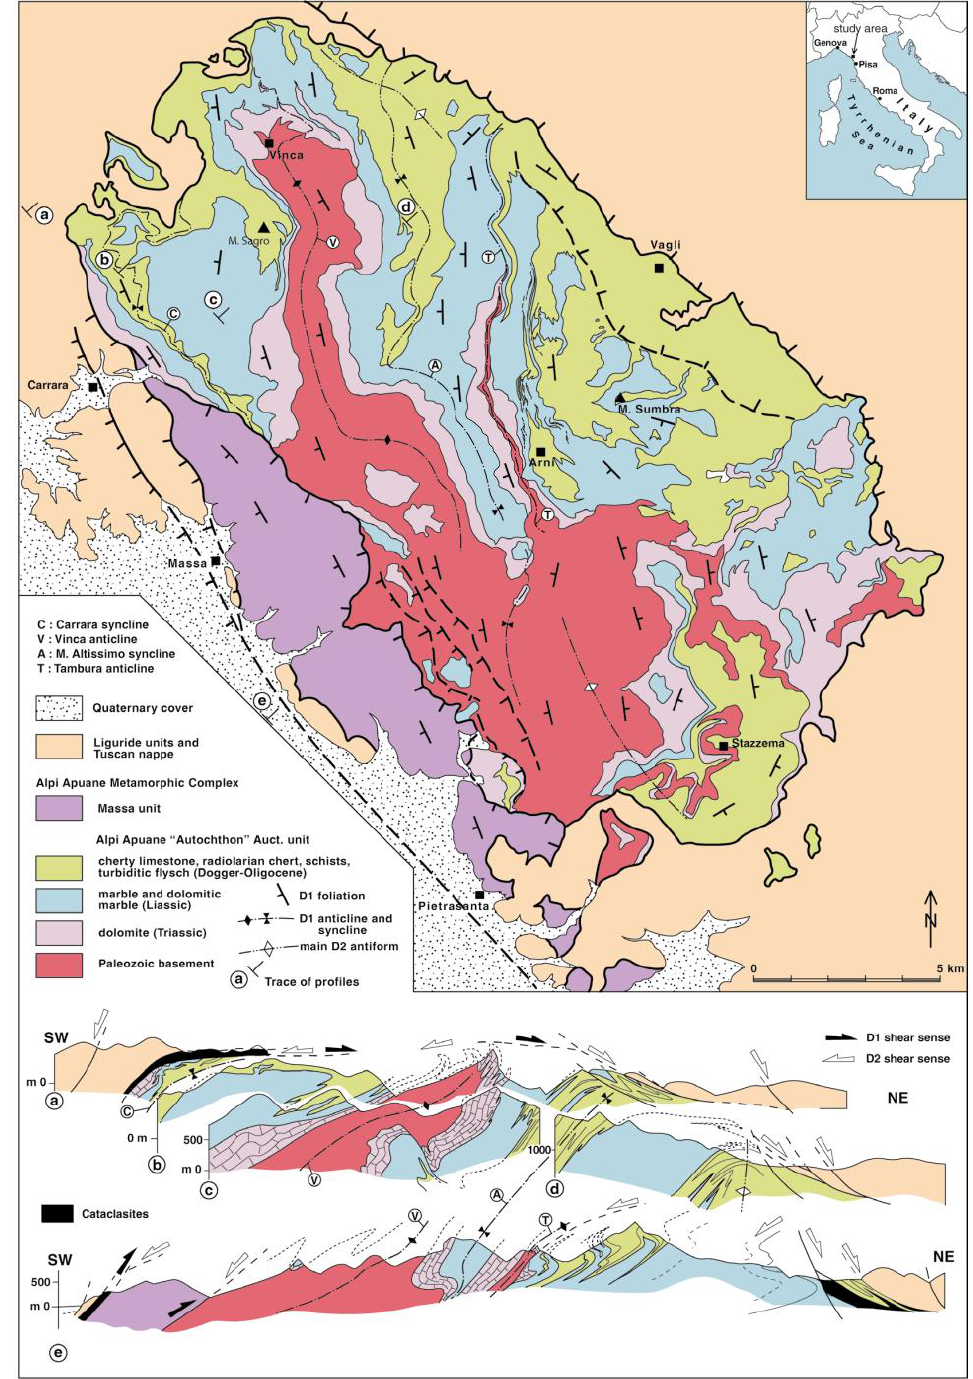
Figure 1. Geological sketch map of the Apuan Alps area (modified after Conti et al., 2004) [13].